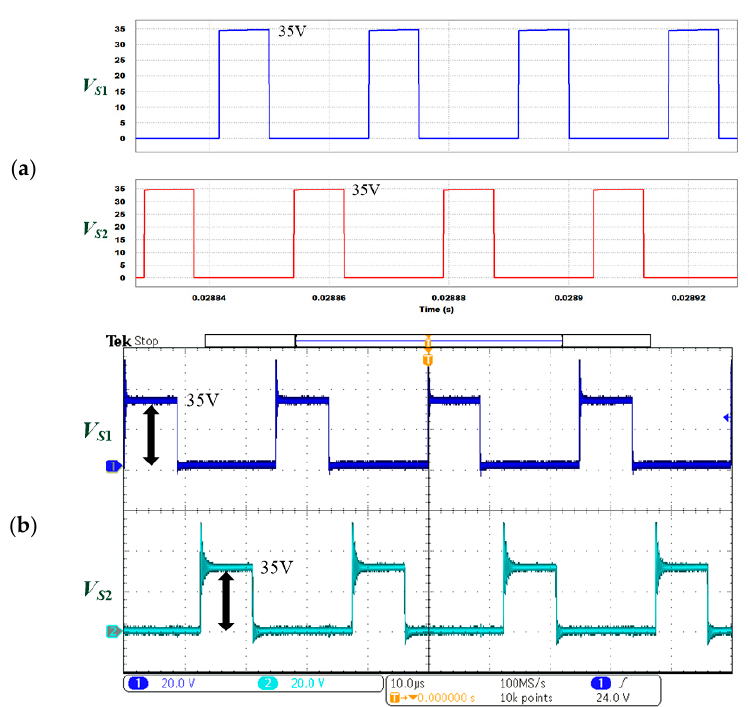
Figure 16. Waveforms of the combined boost converter for the cross voltages across S 1 and S 2 . ( a ) Simulated waveforms; ( b ) Experimented waveforms.